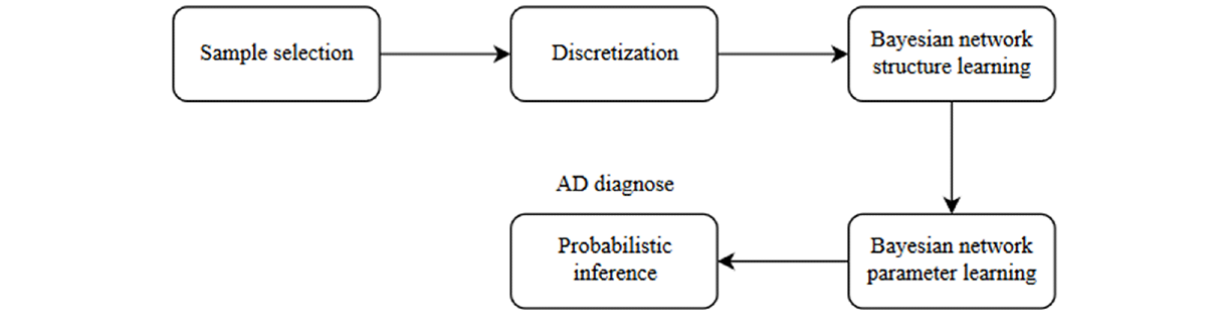
Figure 2. The flowchart of building a Bayesian network. AD: Alzheimer